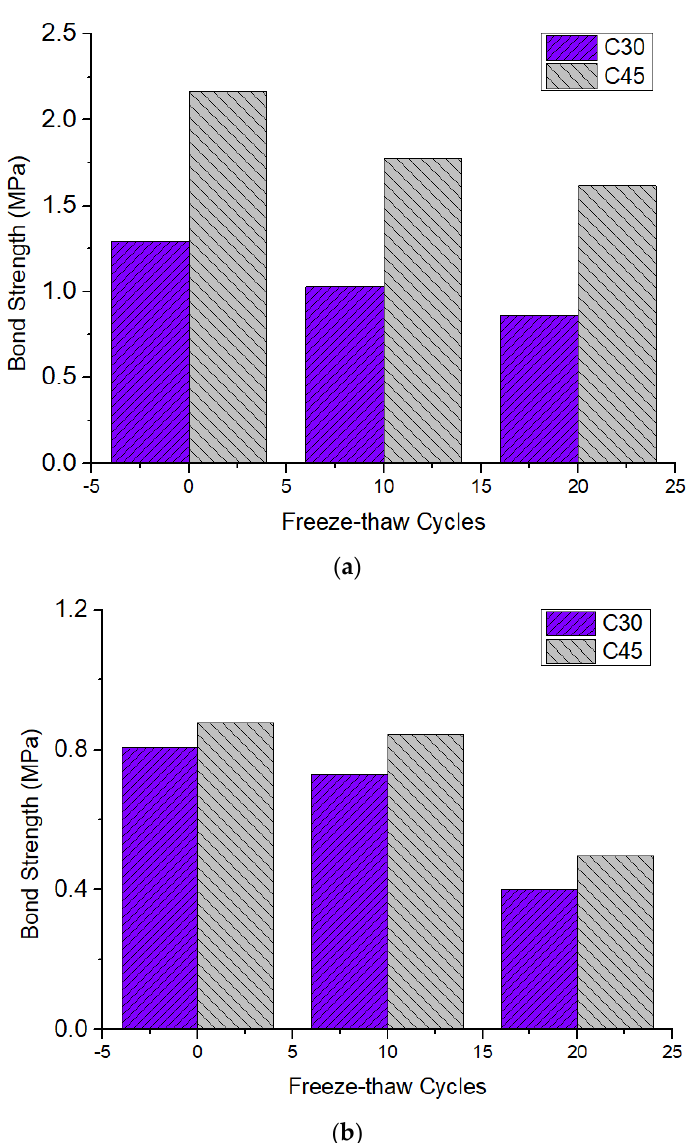
Figure 8. Failure mode of push − out specimens: ( a ) Round steel tube push-out specimen; ( b ) Square steel tube push-out specimen (the data in the figure are averaged).